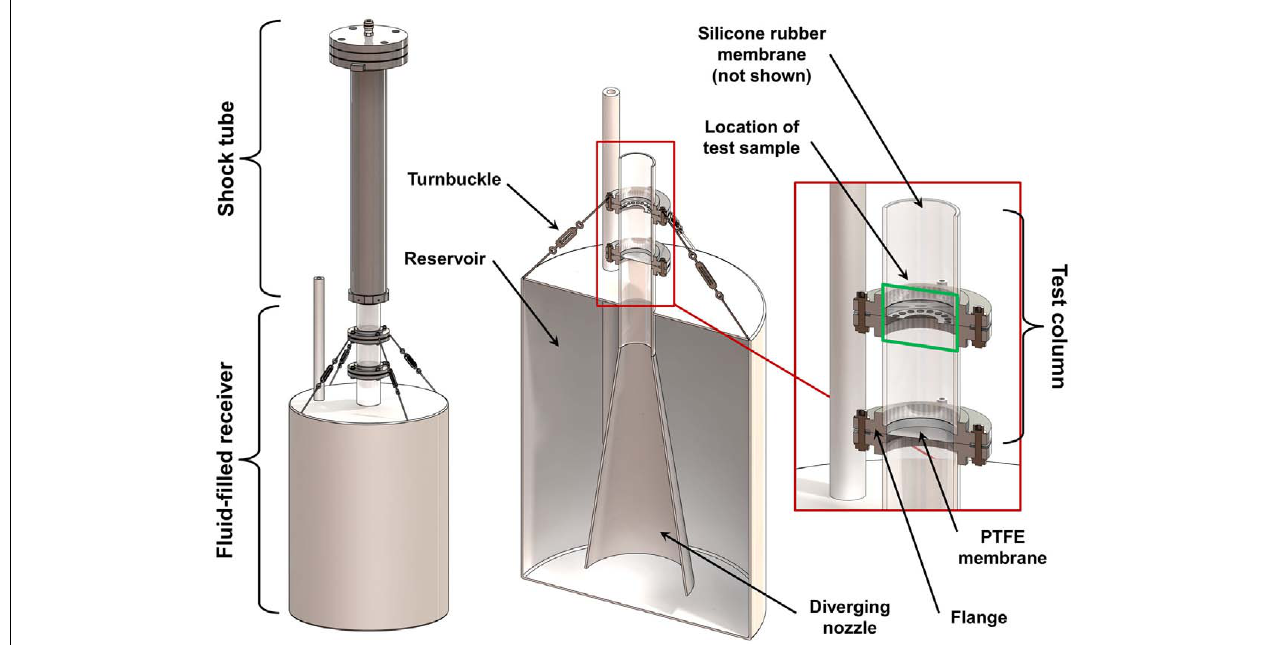
FIGURE 2 | Schematic of the fluid-filled receiver and its placement relative to the shock tube. Section views show the design of the diverging nozzle within the reservoir and the placement of the sample within the test column.